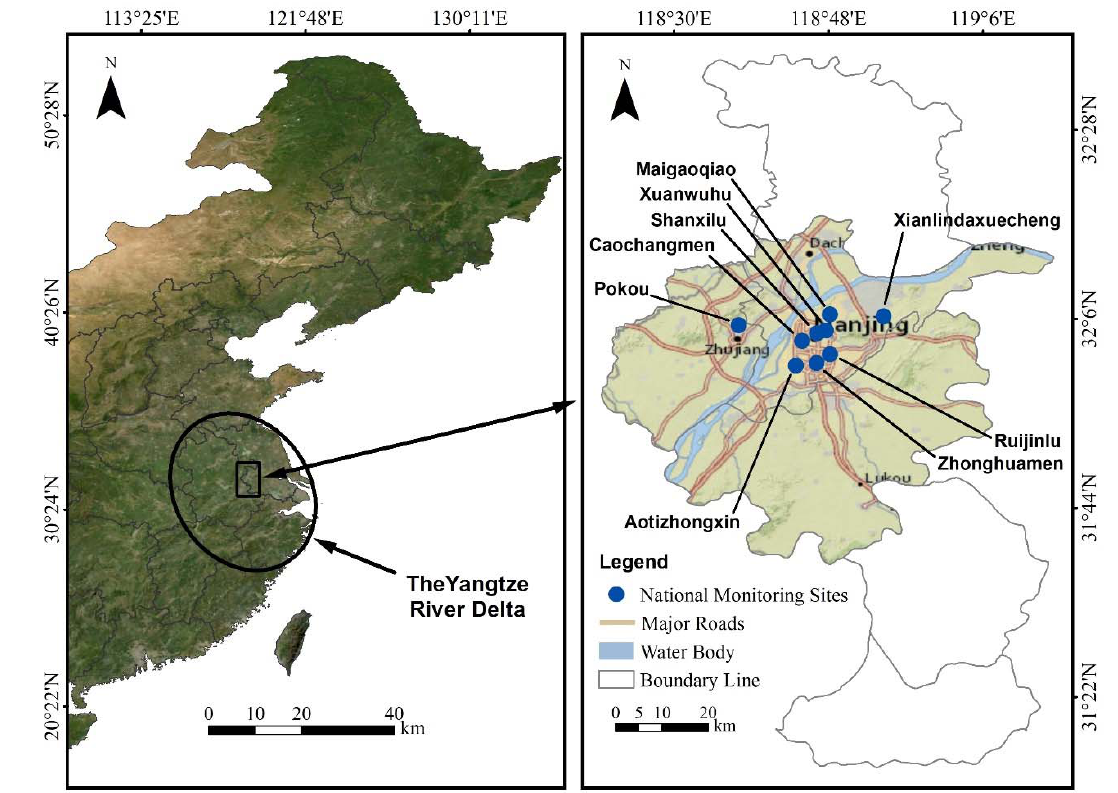
Figure 1. The geographical location and the air pollution monitoring stations in Nanjing.